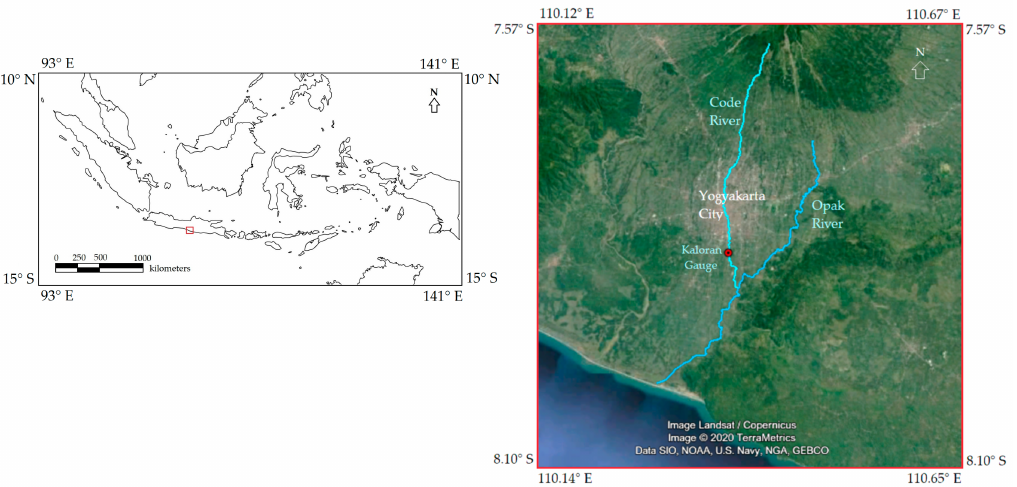
Figure 1. Code River location in southern Indonesia. The small red box in the left figure (map of Indonesia) shows the location of the right figure (satellite image of Yogyakarta